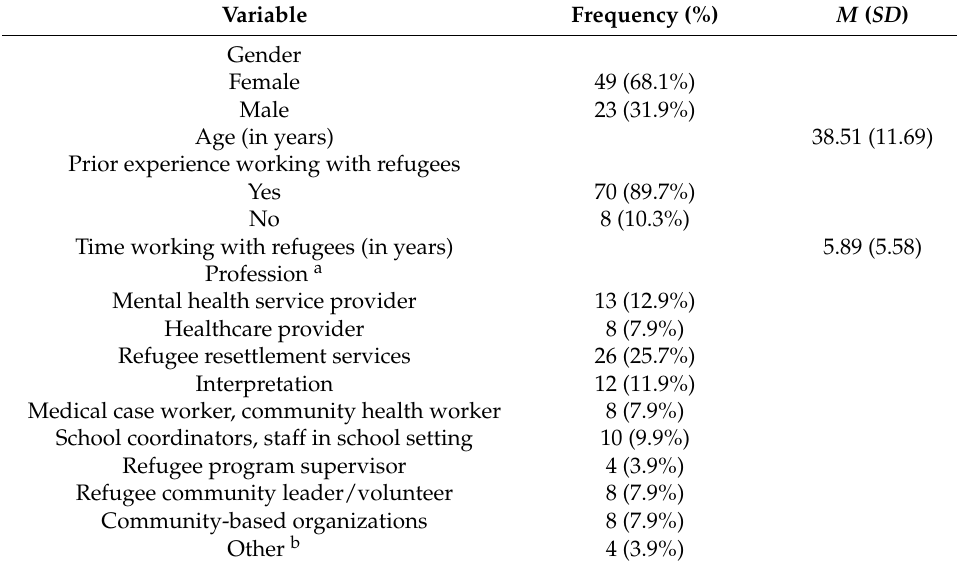
Table 2. Individual Interview Participant Demographics: (Total N =